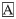
Number of ant genera A and species B with at least n specimens.